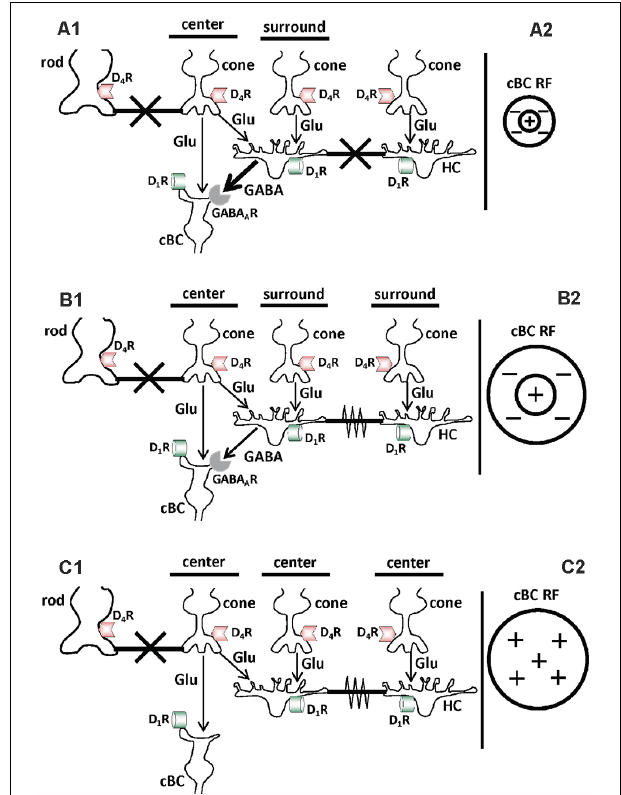
FIGURE 1 | Schematic diagrams showing that in the day the background (ambient) light level modulates chemical and electrical synaptic signaling in the first synaptic layer of the retina (outer plexiform layer) by regulating activation of D 1 receptors on the dendrites of cone bipolar cells and horizontal cells (HCs). (A1,B1,C1) Cones use glutamate (Glu) to signal the dendrites of cone bipolar cells (cBCs) and horizontal cells (HCs). The dendrites of cBCs and HCs have both dopamine D 1 receptors (D 1 Rs) and GABA A Rs, and rod and cone synaptic terminals have dopamine D 4 Rs. Gap junctions, which can function as electrical synapses when open, are located between rod and cone synaptic terminals and between HCs. Evidence has shown that in the day gradual changes in the background (ambient) light level alter GABA A R-mediated chemical synaptic transmission from HCs to cBCs, and electrical synaptic signaling between HCs. (A1,A2) Following maintained ( > 30 min) bright illumination, dopamine release is high and endogenous activation of D 1 Rs on cBCs and HCs is strong, increasing cAMP/PKA in the cells. This in turn uncouples the gap junctions between HCs and increases the expression of functional GABA A Rs on the dendrites of cBCs (A1) . In addition, gap junctions between rods and cones are closed due to endogenous activation of their D 4 Rs (A1) . As a result, the GABA A R-mediated receptive field (RF) surround of cBCs is strong. In addition, cBC surrounds are small, because HCs, which are uncoupled, signal the size of cBC surrounds (A2) . In addition, the HC surround signal, which is opposite in polarity to the cBC center and small in spatial extent, provides lateral inhibition that effectively reduces the size of the cBC center (A2) . (B1,B2) Following maintained dim illumination in the day, dopamine release is lower and endogenous activation of D 1 Rs on cBCs and HCs is weaker, decreasing cAMP/PKA in the cells. This is turn recouples the gap junctions between HCs and decreases the expression of functional GABA A Rs on the dendrites of cBCs (B1) . In addition, gap junctions between rods and cones are closed due to endogenous activation of their D 4 Rs (B1) . As a result, the receptive field surround of cBCs is larger than following maintained bright illumination because HCs are coupled (B2) . In addition, the HC surround signal, ( Continued